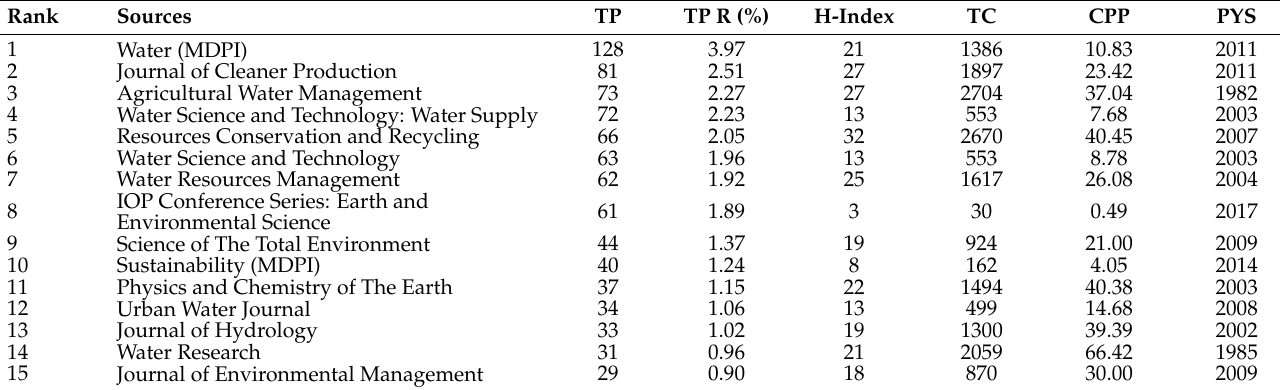
Table 3. The top 15 productive sources in RWH field.